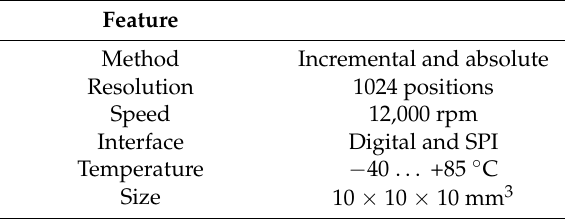
Table 2. The most important features of the encoder; SPI—Serial Peripheral